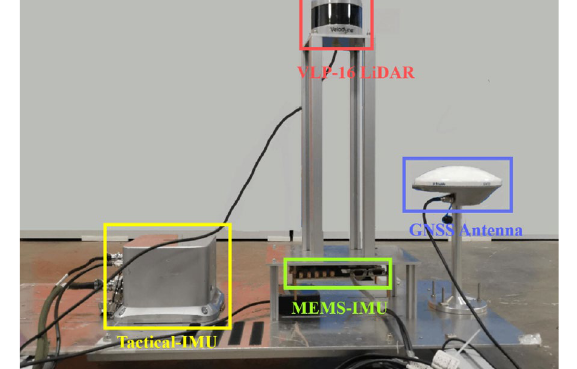
Table 1 Strategies and models in multiple GNSS PPP processing